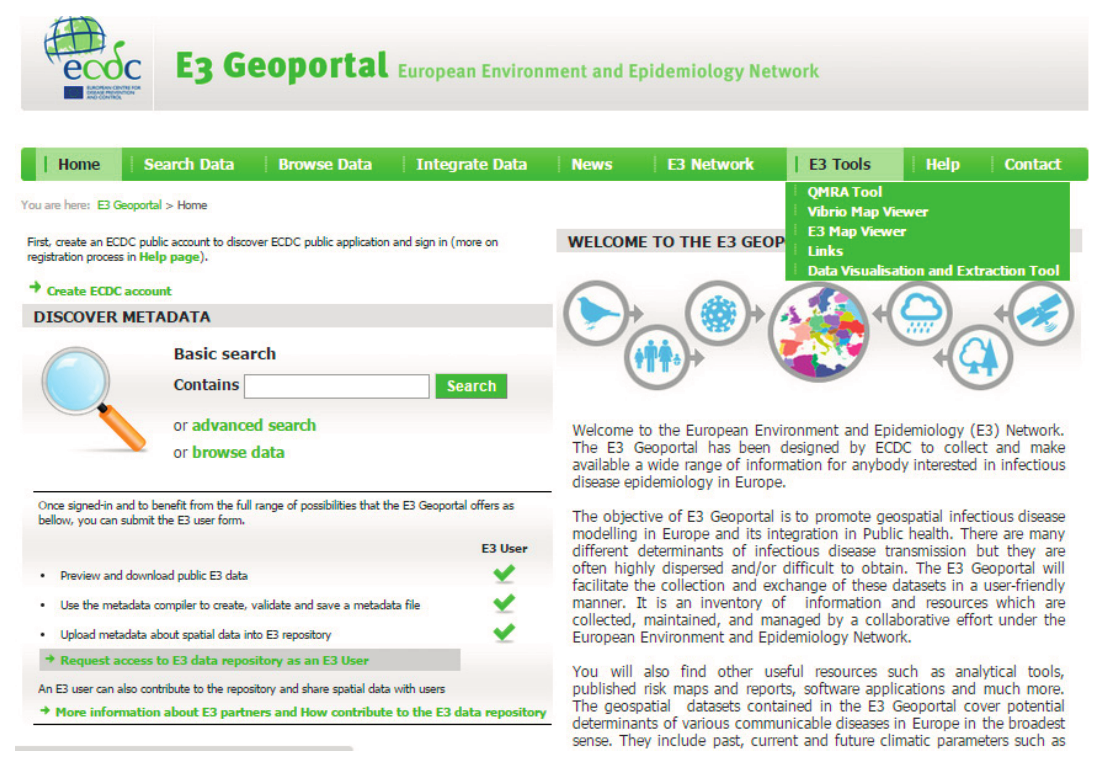
Figure 2. Screen shot of the E3 geoportal of the european environment and epidemiology (E3) Network